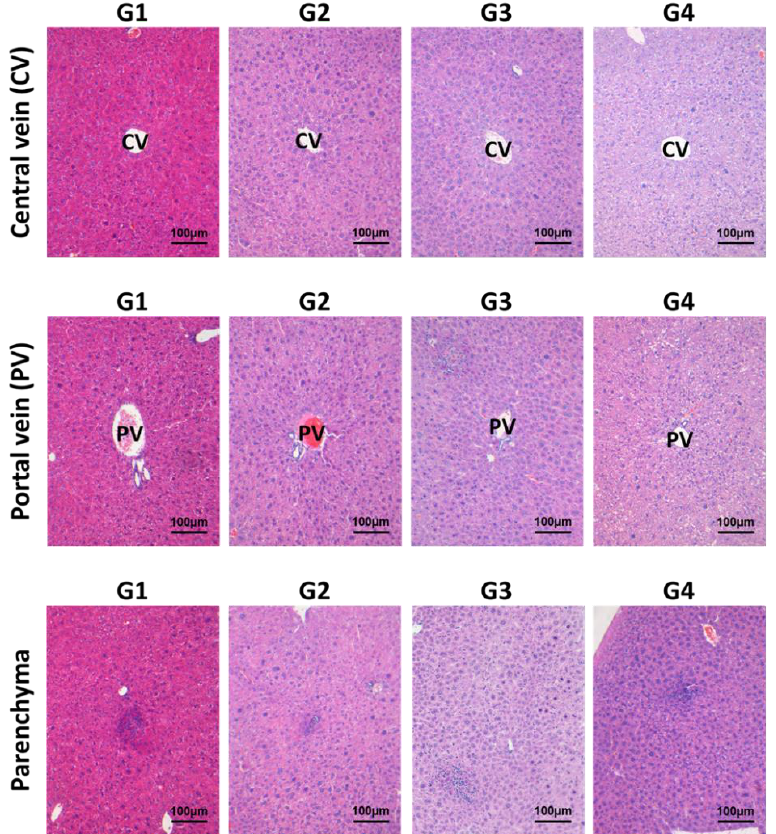
Figure 2. Effects of INO95 and INO20 on hepatitis inflammation in the repeated dose toxicity study. In the experiment, liver was collected on day 91 for histology analysis. Section slides were